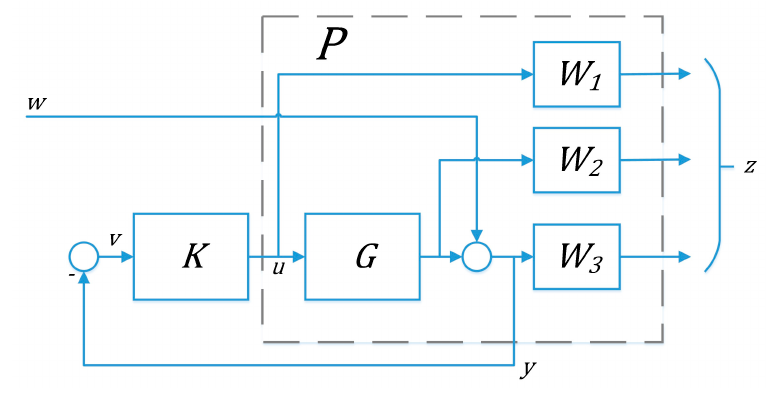
Figure 6. Mixed sensitivity optimization scheme.